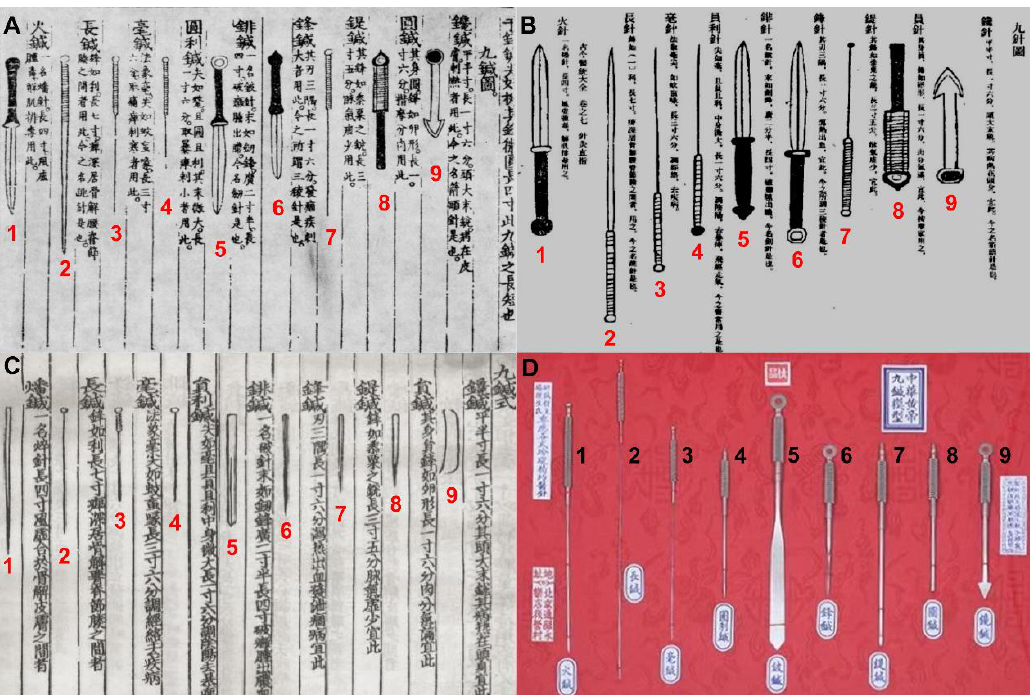
Figure 1. Nine-needle illustrations and model. (A) Illustration of nine needles from Zhen Jiu Da Cheng [ 针灸大成 , Great Compendium of Acupuncture and Moxibustion] [1]. (B) Illustration of nine needles in Gu Jin Yi Tong Da Quan [ 古今医统大全 , Great Collection of Ancient and Modern Medicine] [2]. (C) Illustration of nine needles from Zhen Jiu Zhai Ying Ji [ 针灸摘英集 , Collection of Acupuncture and Moxibustion Digests] [2]. (D) Modern nine-needle model made according to the description of nine- needles from Huang Di Nei Jing [ 黄帝内经 , The Yellow Emperor’s Inner Classic of Medicine] [3]. The same number in each figure represents the same kind of needle.